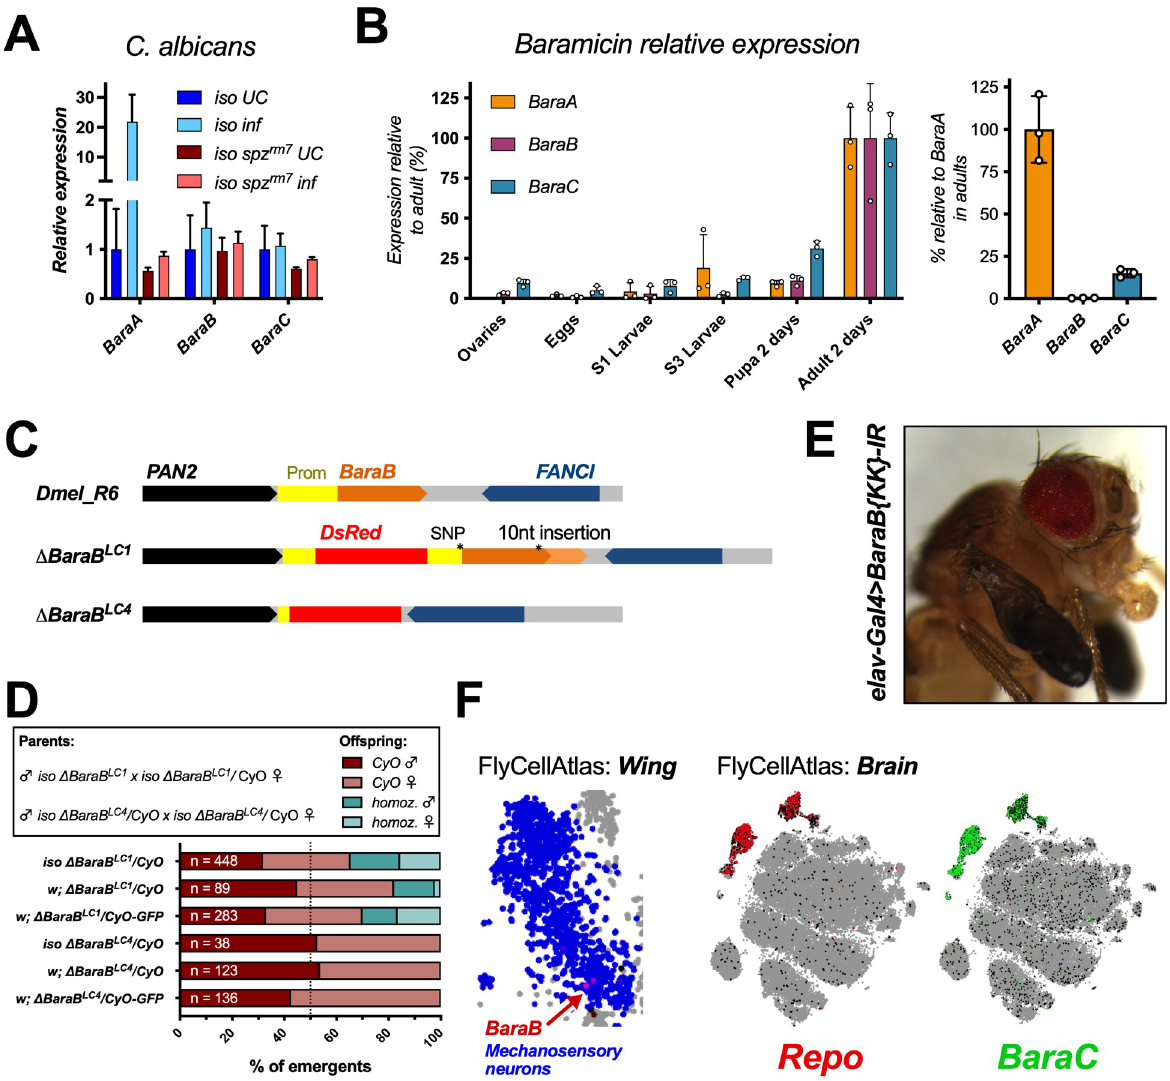
Fig 3. D . melanogaster BaraB and BaraC have neural functions. A) Only BaraA is immune-induced. BaraB and BaraC do not respond to infection, though basal BaraC expression relies on Toll signalling (S3C Fig). B) Time series of whole animal Baramicin expression over the course of development. Expression values are normalized within each gene, with expression in the adult set to 100% (left panel). For context, normalizing each gene to BaraA in adults shows that BaraC and especially BaraB expression is much lower at a whole fly level (right panel). C) Δ BaraB mutations generated in this study. Δ BaraB LC1 is an incidental hypomorph with reduced BaraB expression (S3A Fig), while Δ BaraB LC4 has the intended genetic replacement of BaraB with a DsRed cassette. Both mutations cause expression of DsRed in the eyes, ocelli, and abdomen. D) Partial lethality of Δ BaraB LC1 hypomorphs or complete lethality of Δ BaraB LC4 null flies in varied genetic backgrounds. E) The partial expansion wing phenotype is copied by BaraB gene silencing using the neural driver elav-Gal4 . F) Specific wing mechanosensory neurons seem to express BaraB in adults. Meanwhile the BaraC gene almost perfectly matches the expression pattern of glia specific Repo -expressing cells in single cell RNA sequencing of the adult fly brain